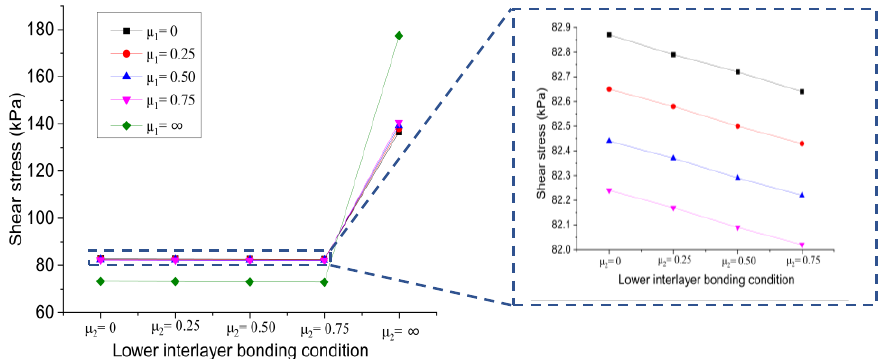
Figure 13. Influence of lower interlayer bonding condition on shear stress at the bottom of lower